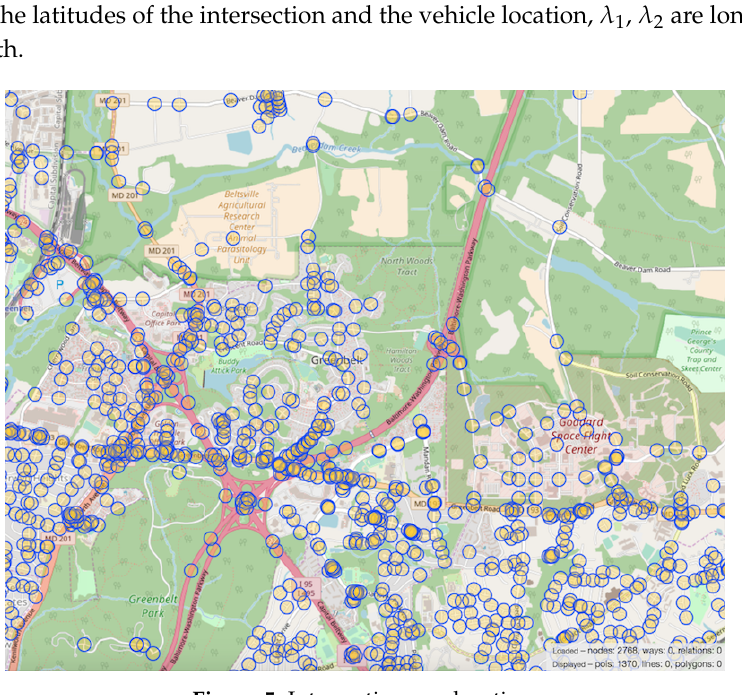
Figure 5. Intersection